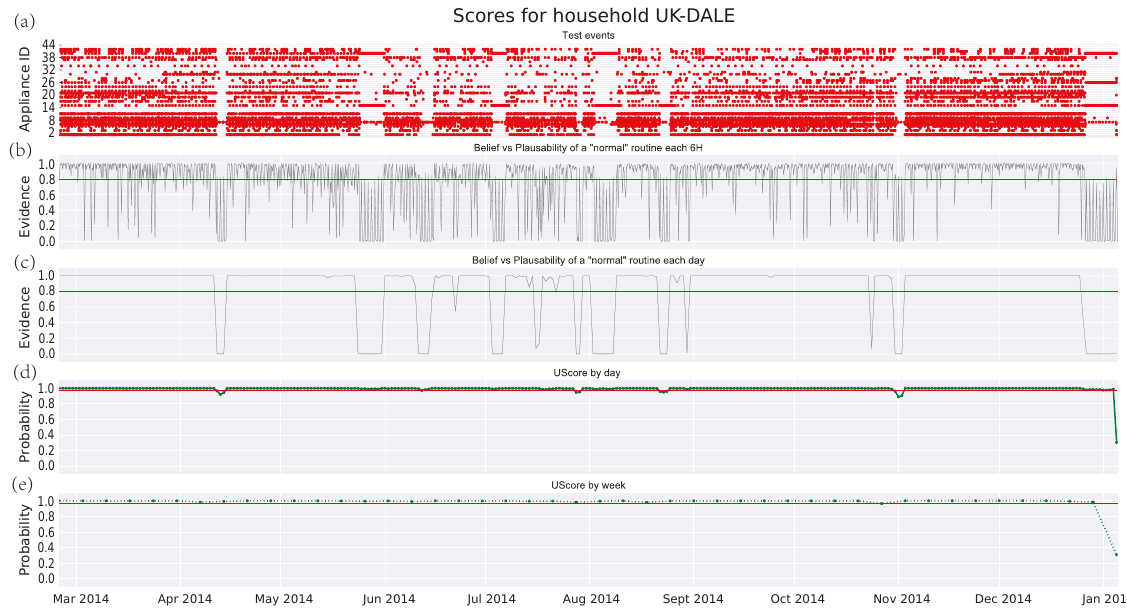
Figure 7. Score for test events in household no. 1 from UKDALE dataset: ( a ) test events; ( b ) DST score every 6 h; ( c ) DST score by day: ( d ) union probability score by day; and ( e ) union probability score by week.